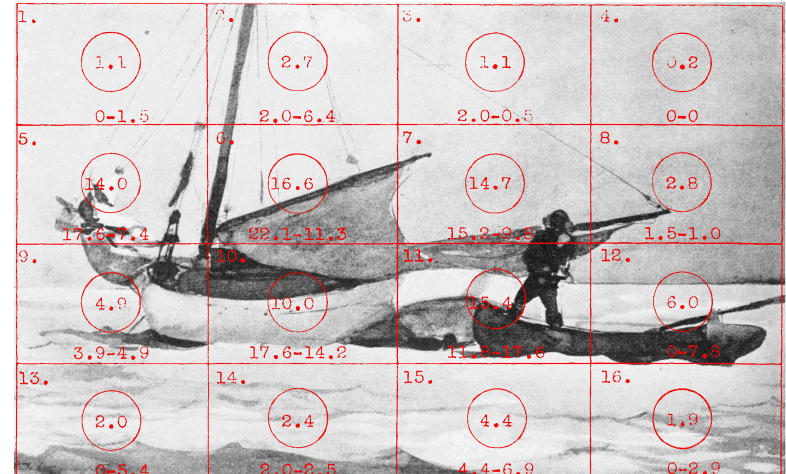
Figure 6. Regional variations . A grid of 16 rectangles superimposed on a photograph of Stowing the sail – Bahamas by Winslow Homer. Numbers in the circles represent the percentage of the first 18 fixations which fall in each rectangle; numbers separated by dash indicate the percentage of the first three and last three fixations falling in each rectangle. (Adapted from Picture 9 and Plate XVI in Buswell, 1935.)